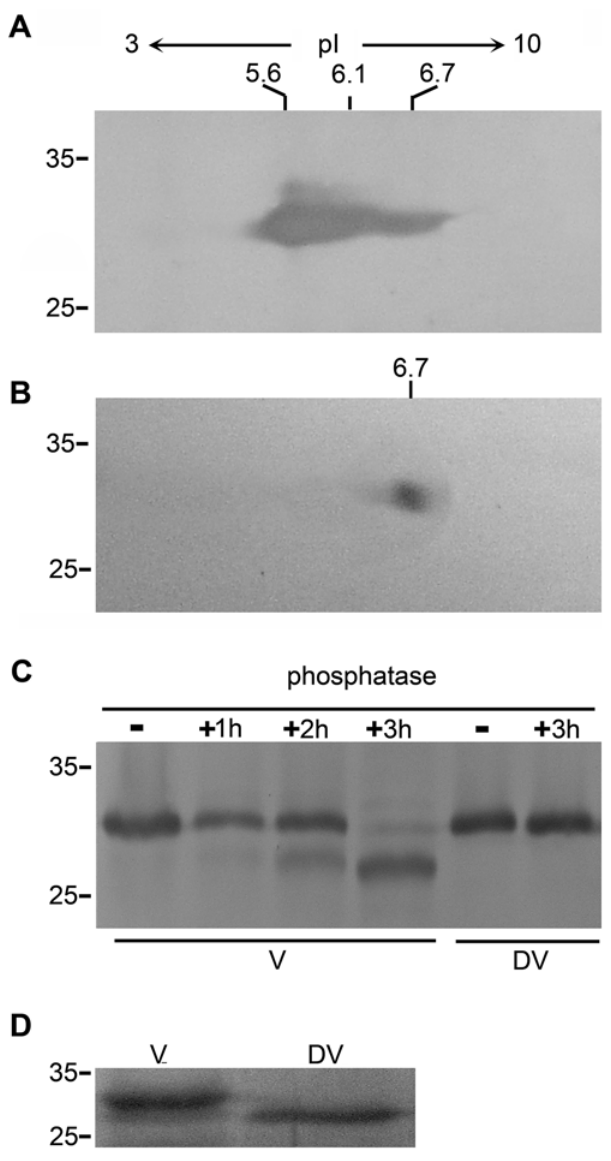
Figure 3. Immunoblot analysis of VER2 separated on 2-D electrophoresis and dephosphorylation of VER2 by phospha- tase in vernalized and devernalized wheat plants. (A) VER2 was separated into 3 main spots with pI=5.6, 6.1 and 6.7, respectively, in vernalized wheat plants. (B) VER2 was detected as one spot with pI=6.7 in devernalized wheat plants. (C) VER2 was immunoprecipitated and then treated with protein phosphatase for the time shown in vernalized and devernalized plants. (D) Immunoblot analysis showing the difference of migration distance of VER2 in vernalized and devernalized materials. The samples were separated by electrophoresis for enough time until the marker band with the molecular weight of 25 kDa shifted to the forefront of the 8 cm